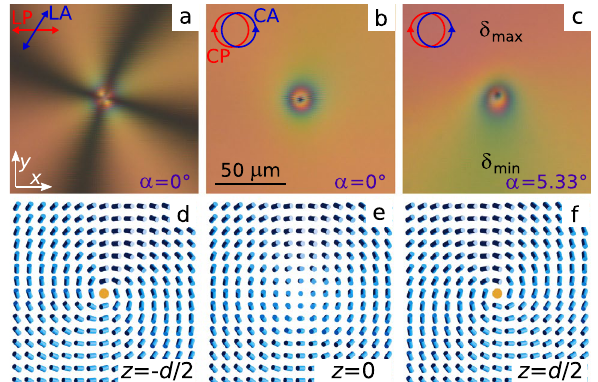
Figure 6. POM photos of chiral nematic with boojum of strength m = + 1 and the phase on the top substrate ξ d / 2 = − 106 ◦ taken in the crossed at angle 58 ◦ LP and LA at the LP polariser orientation 0 ◦ ( a ), in the crossed circular polarisers at the light incidence angle α = 0 ◦ ( b ) and α = 5.33 ◦ ( c ). The corresponding director field on the bottom substrate ( d ), at the layer centre ( e ) and on the top substrate ( f ) calculated by Eqs. (7) and